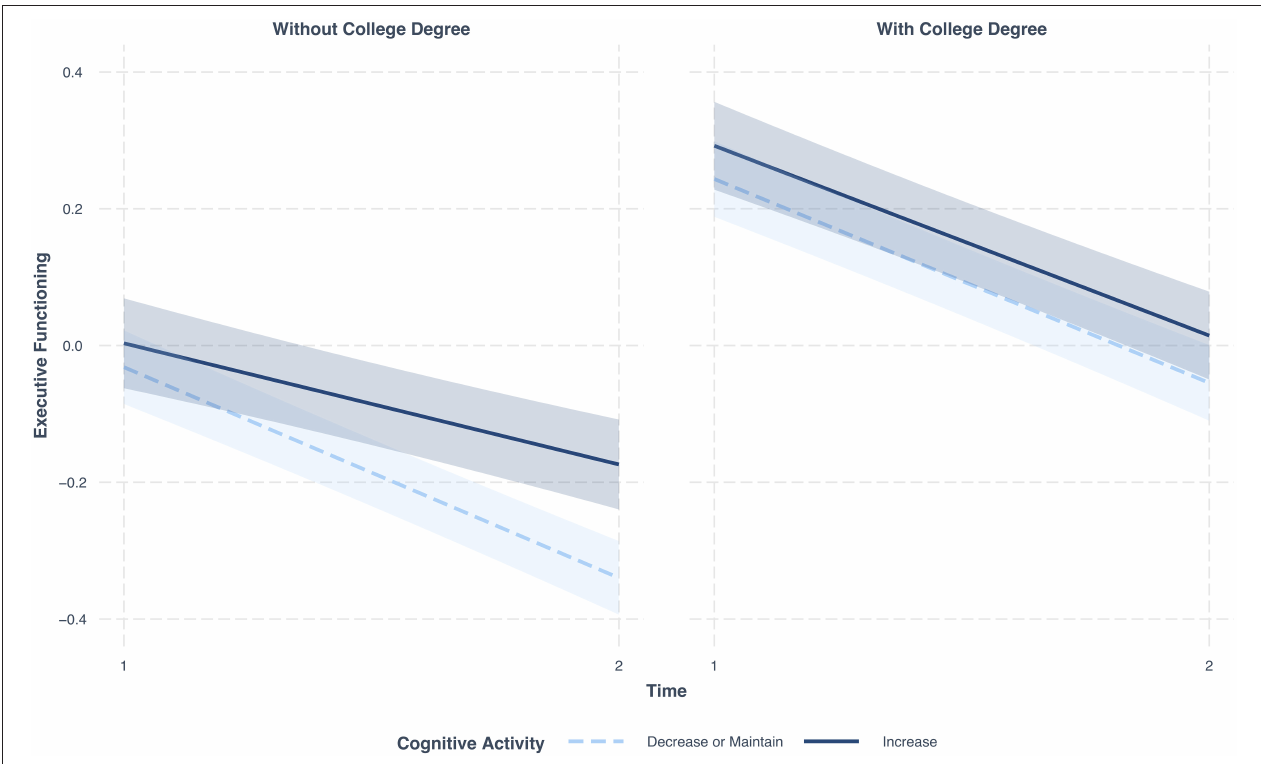
FIGURE 2 | Changes in EF over time in individuals with a college degree (left) and without a college degree (right); Dark blue, change in EF in individuals who increased their cognitive activity across the 9 years; Light blue, change in EF in individuals who decreased or maintained their cognitive activity across the 9 years; Figures include 95 percent confidence intervals; Covariates in models, cognitive activity at M2, income, age, sex, frequency of physical activity, functional health, self-rated health, BMI, depression, diabetes, head trauma, hypertension, smoking, sleep problems, vitamin C, alcohol or